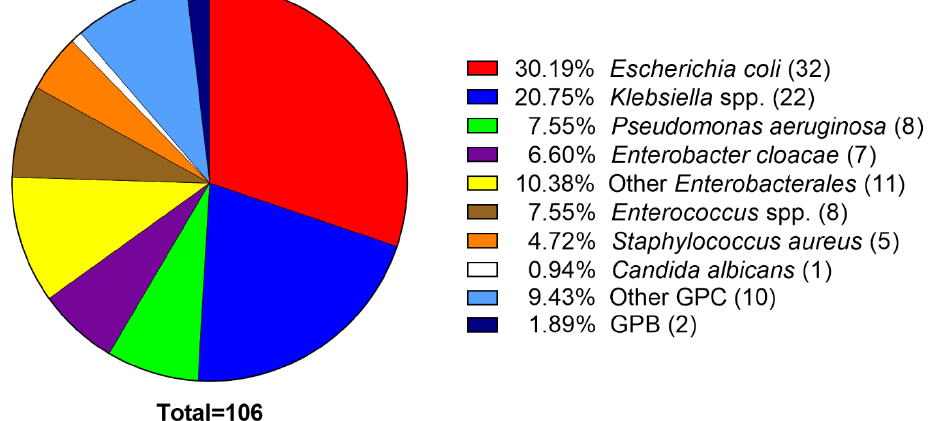
Figure 1. Distribution of the 106 uropathogenic isolates. Numbers in parentheses indicate numbers of isolates. Klebsiella spp. includes K. pneumoniae (18), K. oxytoca (2), and K. aerogenes (2); other Enterobacterales includes Serratia marcescens (3), Citrobacter freundii (3), C. koseri (2), Proteus mirabilis (2), and Hafnia alvei (1). Enterococcus spp. includes E. faecalis (6) and E. faecium (2). Other GPC isolates include Streptococcus agalactiae (5), S. anginosus (1), Staphylococcus epidermidis (2), Aerococcus urinae (2); GPB isolates are Lactobacillus sp. (1) and Actinomyces neuii (1). GPC, Gram-positive cocci; GPB, Gram-positive bacilli.